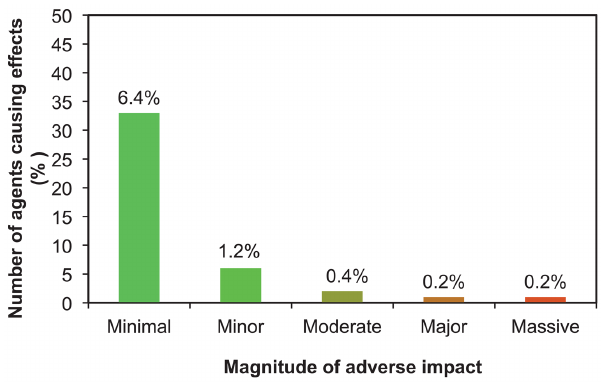
Figure 2. Number of biological control agents causing adverse impacts on non-target plant taxa, by magnitude.